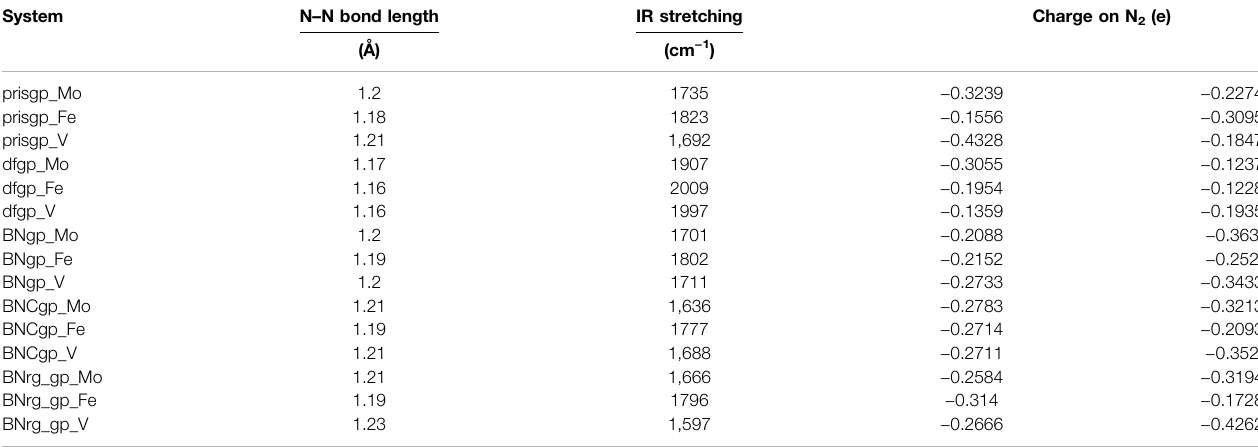
TABLE 3 | Structural, electronic, and vibrational propertiesof various catalytic systems for N 2 activation (pristine graphene, defective graphene, BN-doped graphene, BNC- ring graphene, and BN-ring graphene are abbreviated as prisgp, dfgp, BNgp, BNCgp, and BNrg_gp). System N – N bond length IR stretching Charge on N 2